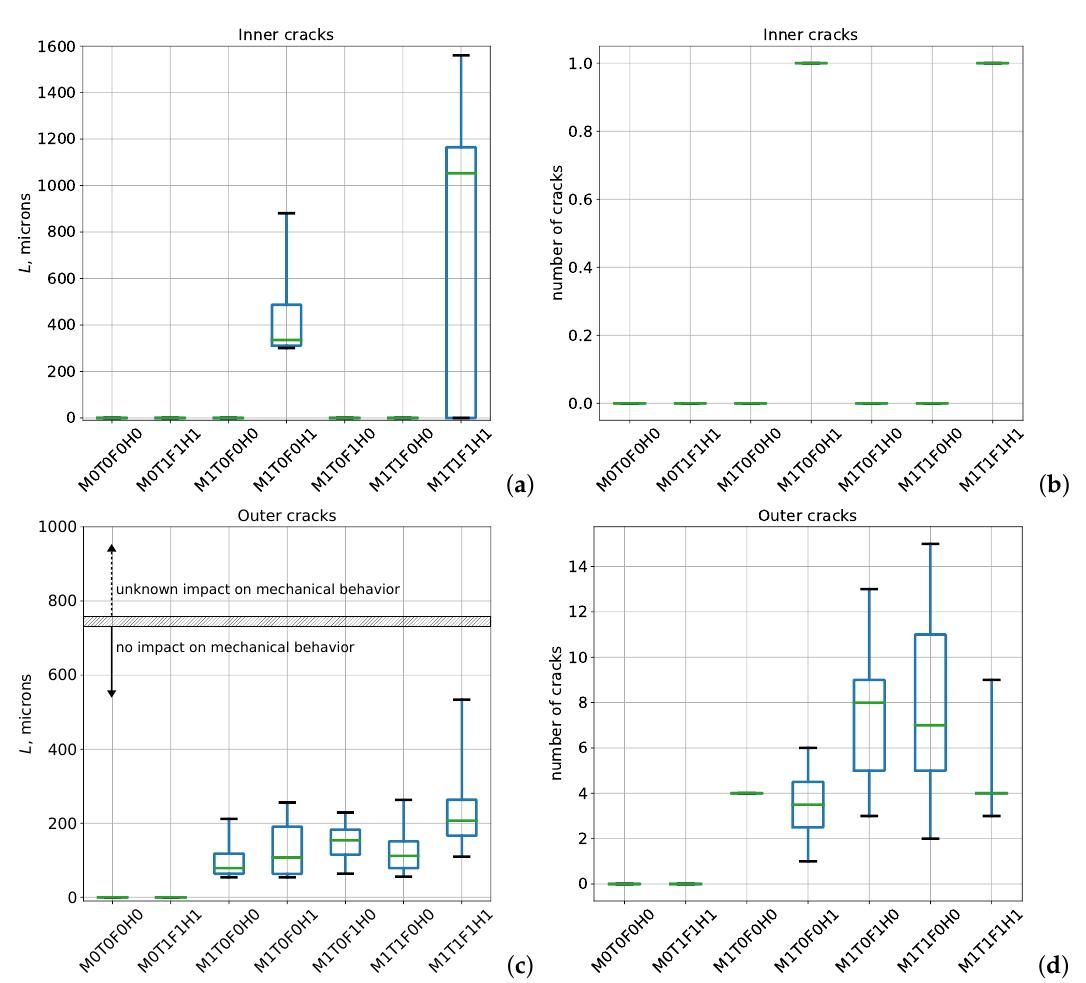
Figure 6. Liquid metal embrittlement cracks. ( a ) Inner crack length, ( b ) number of inner cracks, ( c ) outer crack length and ( d ) number of outer